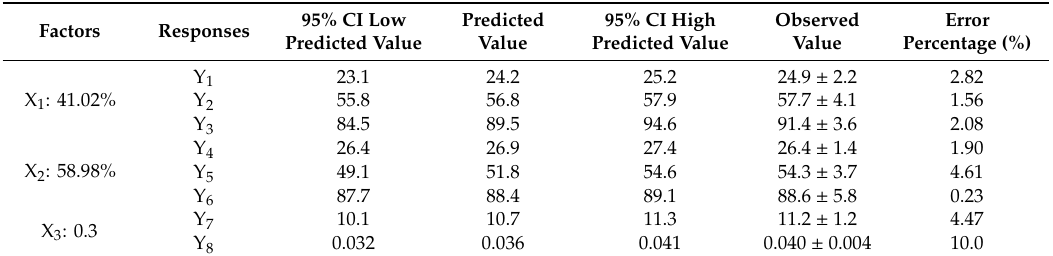
Table 6. Predicted and actual values of suggested solutions.